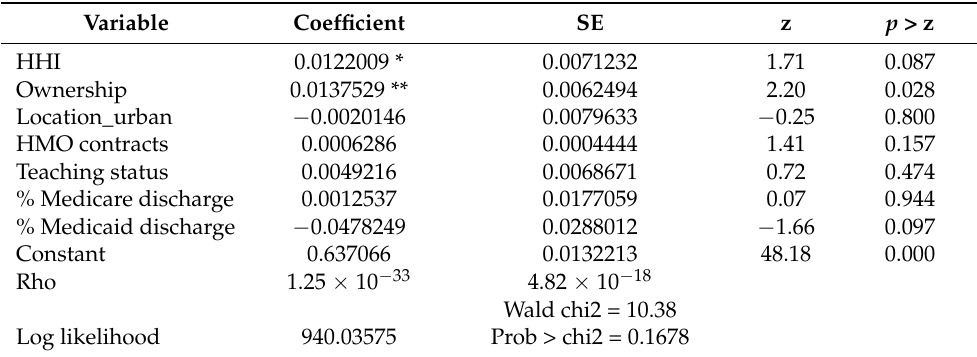
Table 4. Results of Tobit regression